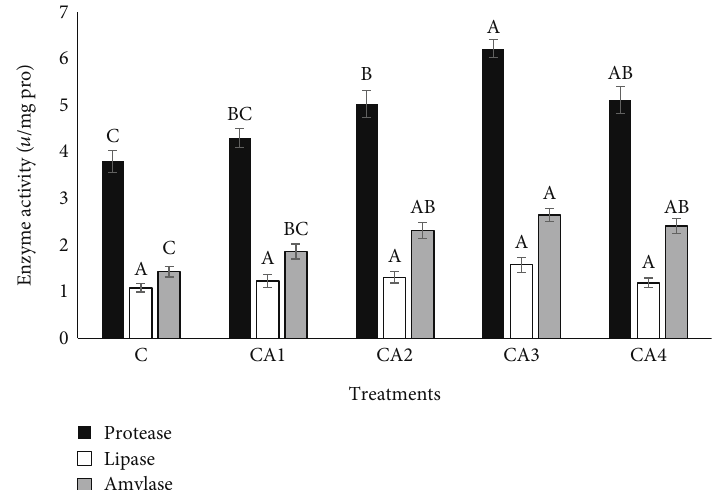
Figure 2: Digestive enzyme activity of O. mykiss fed with di ff erent levels of ChA for 60 days. Columns assigned with di ff erent superscripts signi fi cantly di ff er ( P < 0 : 05 ). Values are presented as mean ± SE . Table 3: The serum immune parameters of O. mykiss fed with di ff erent levels of ChA after a 60-day feeding trial. Di ff erent experimental diets Parameter